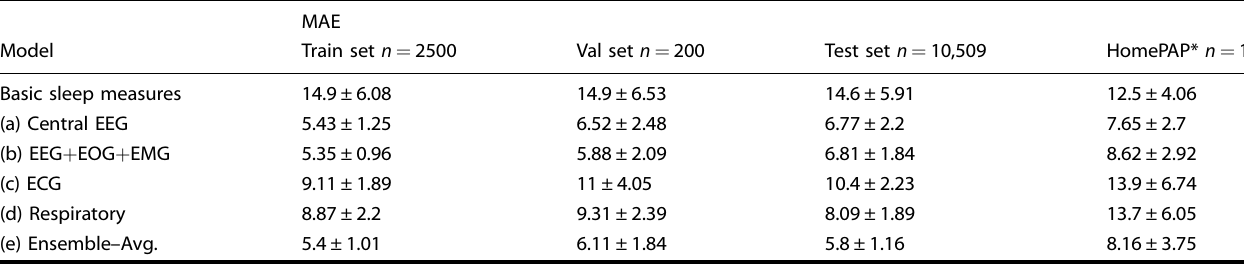
Table 1. Mean absolute error of age estimation